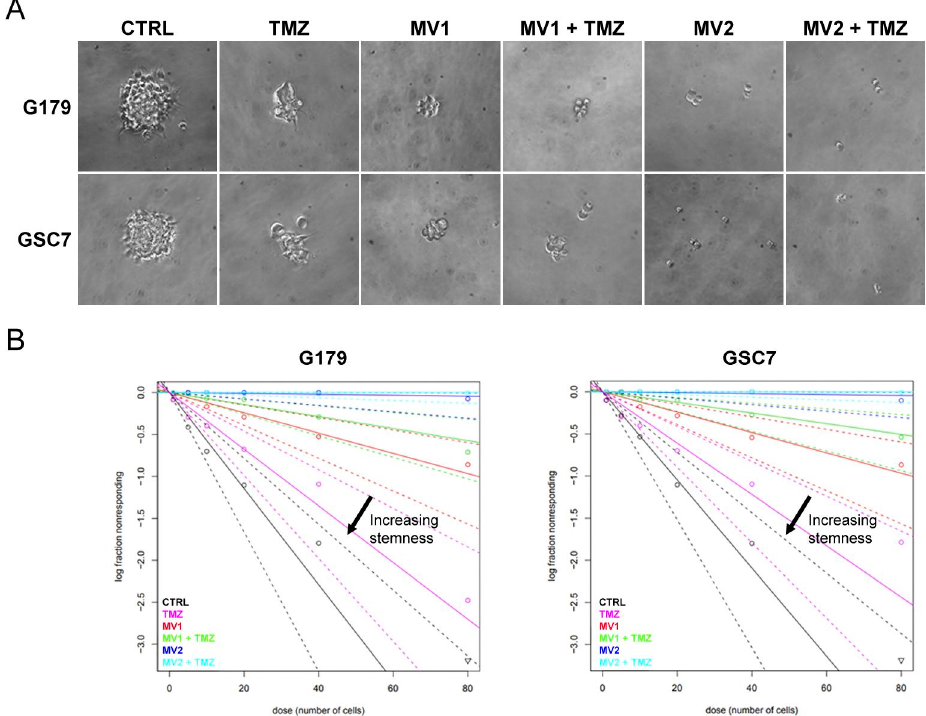
Figure 5. In vitro analysis of neurospheres formation using the limiting dilution assay (LDA). ( A ) representative images of neurospheres in G179 and GSC7 following 7 days of TMZ (200 µM) and/or MV1035 (MV1 25 µM; MV2 50 µM) treatments. Images were captured with Leica DFC290 microscope camera with 20× magnification. ( B ) LDA data analysis by the extreme limited dilution assay (ELDA) tool. The amount of initially seeded cells ( x axis) is plotted against the log fraction of non-responders corresponding to wells without any detected sphere ( y axis). The slope of the line represents the log-active cell fraction. The dotted lines give the 95% confidence